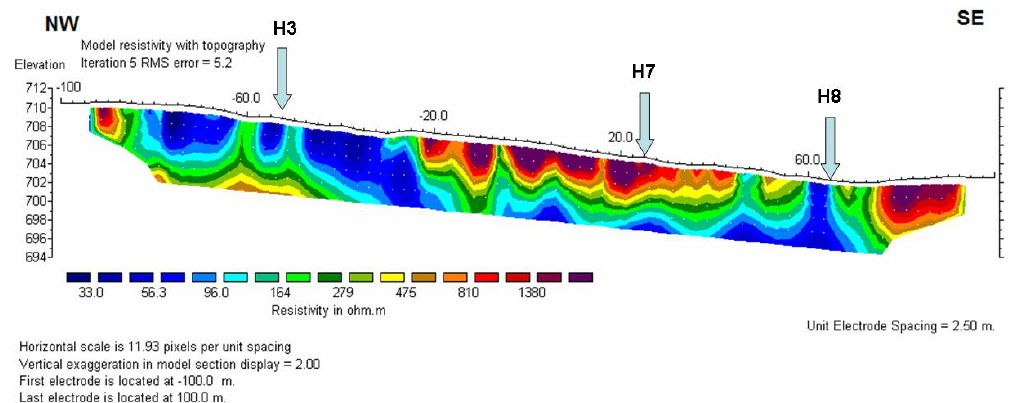
Fig. 7. ERI pseudosection of a transect along the wetland. Wenner short, note 2 × vertical scale